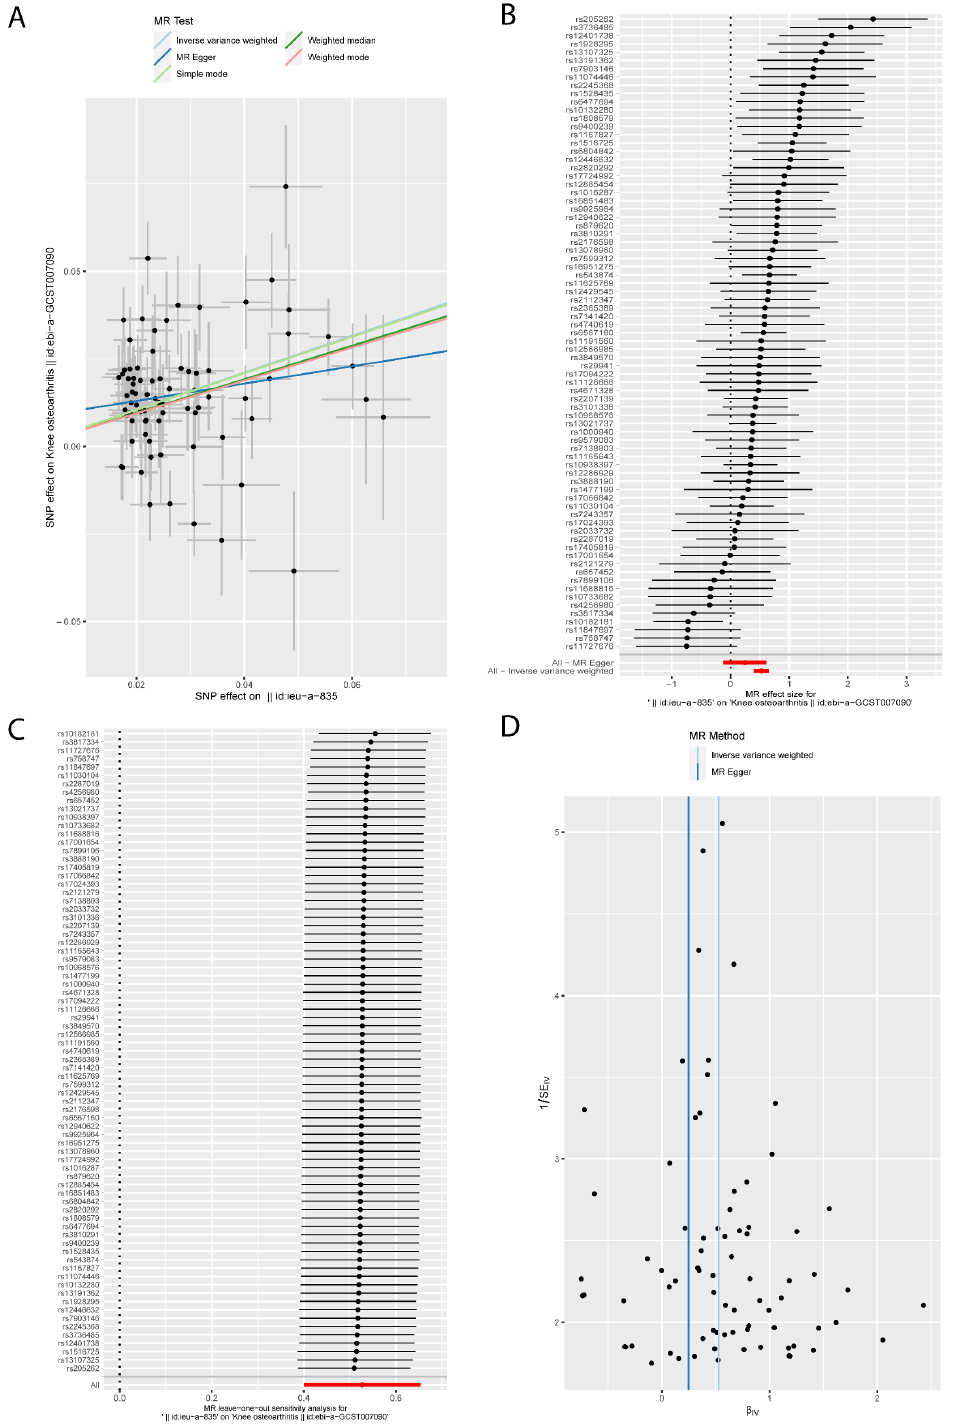
Figure 2. The MR results of body mass index on knee osteoarthritis. ( A ) Scatter plot about the causal effect of body mass index on knee osteoarthritis. ( B ) Forest plot for the overall causal effects of body mass index on knee osteoarthritis. ( C ) Leave-one-out analysis for the causal effect of body mass index on knee osteoarthritis. ( D ) Funnel plot of SNPs related to body mass index and knee